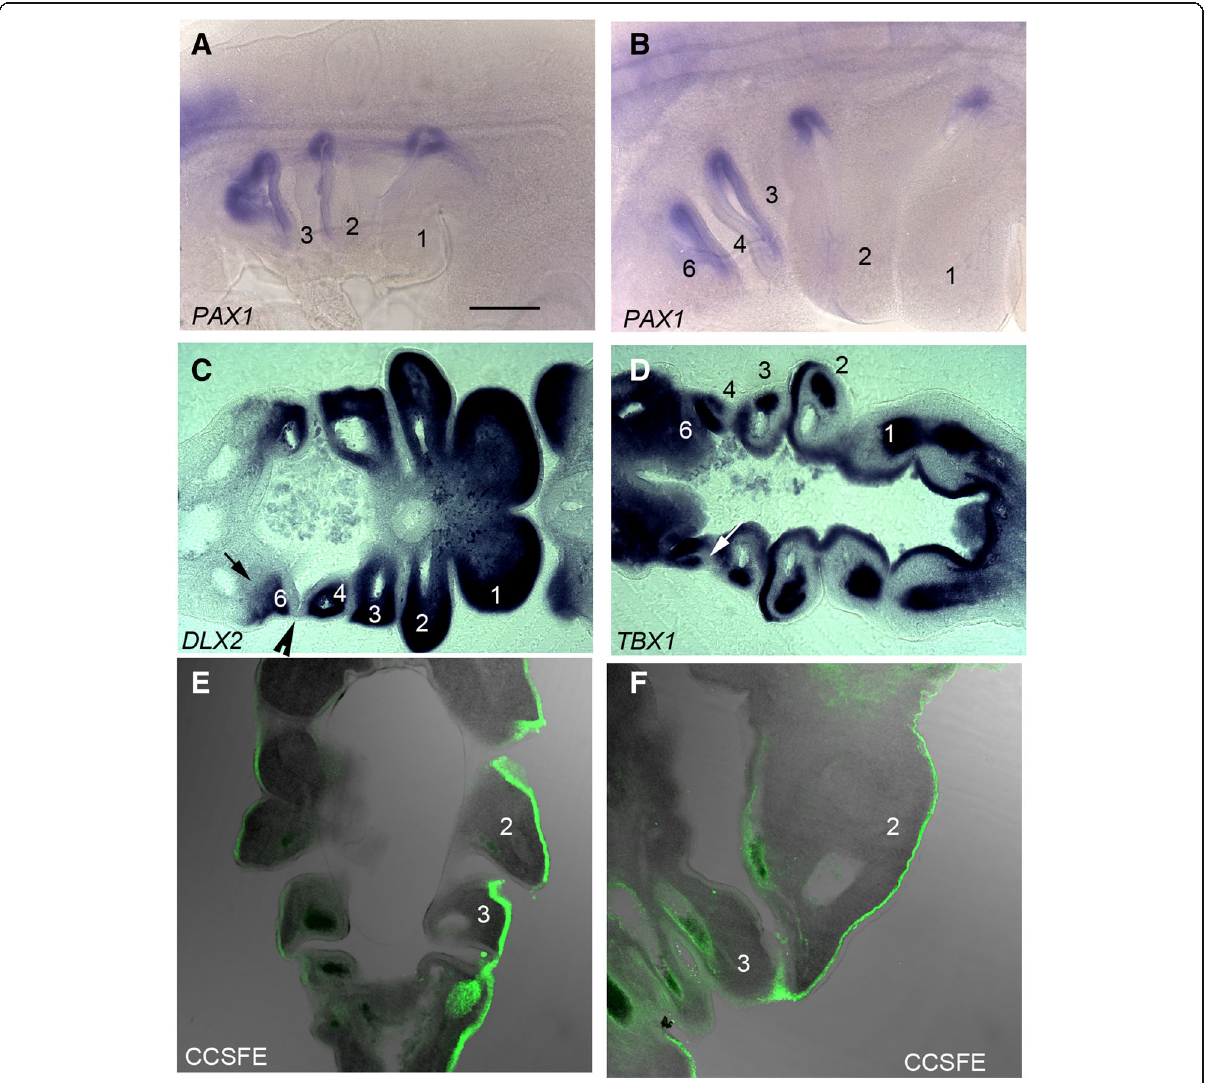
Fig. 2 The generation and remodelling of the pharyngeal segments. a Side view of a HH17 chick embryo, the three fully formed anterior arches can be seen while at HH21 ( b ) the full complement of arches have formed. PAX1 highlights the position of the intervening pouches. ( c ) Longitudinal section of a HH21 chick embryo, DLX2 expression shows the neural crest component of the arches. Noticeably, the caudal edge of arch 6 has no clear definition; highlighted by the black arrow while the anterior limit of this arch is delineated by the pouch of contact between the fourth pouch and the overlying ectoderm, indicated by the black arrowhead. d Longitudinal section of a HH21 embryo, TBX1 expression demonstrates the relative positions of the mesoderm components of each of the arches as well as the pharyngeal endoderm and pouches. A sizeable mesodermal population can be seen in arches 1, 2, and 3. Arch 4 by comparison only has a reduced mesoderm component; indicated by the white arrow. At HH20 ( e ) the second arch is beginning to expand and by HH24 ( f ) it has overgrown the posterior arches. The arches are numbered in all panels. Scale bar = 0.1